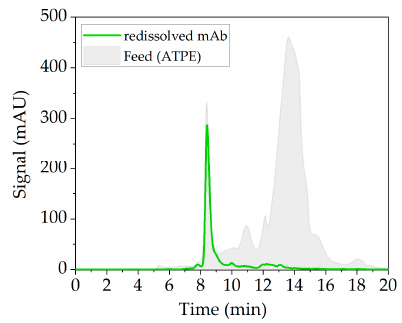
Figure 7. Size exclusion chromatography (SEC) chromatogram of the feed obtained after aqueous- two phase extraction (ATPE) (gray). Supernatant after precipitation is eliminated through dead end filtration. Redissolved mAb in sodium phosphate buffer I depicted in green.